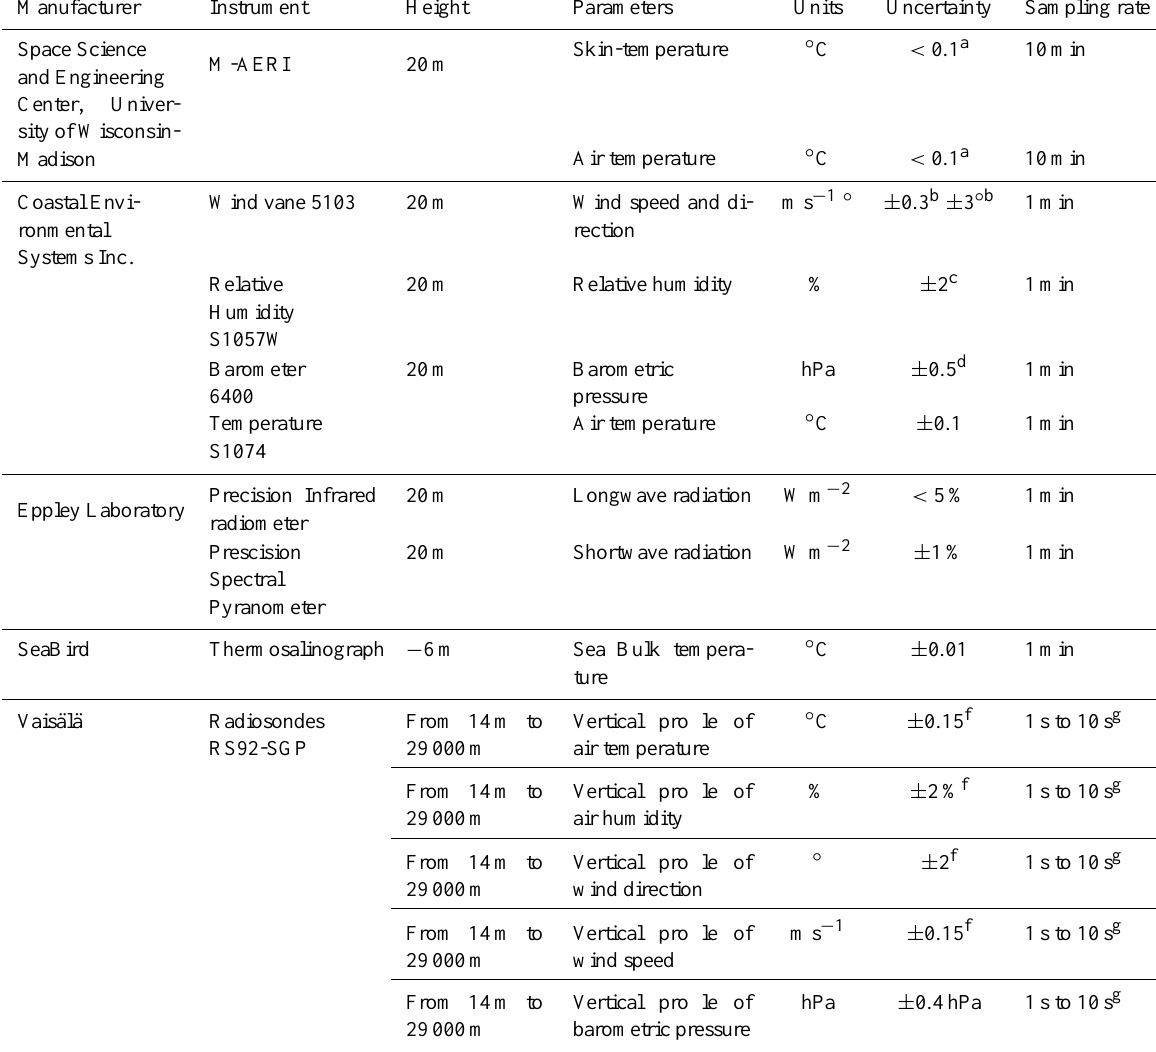
Table 1. Instrument